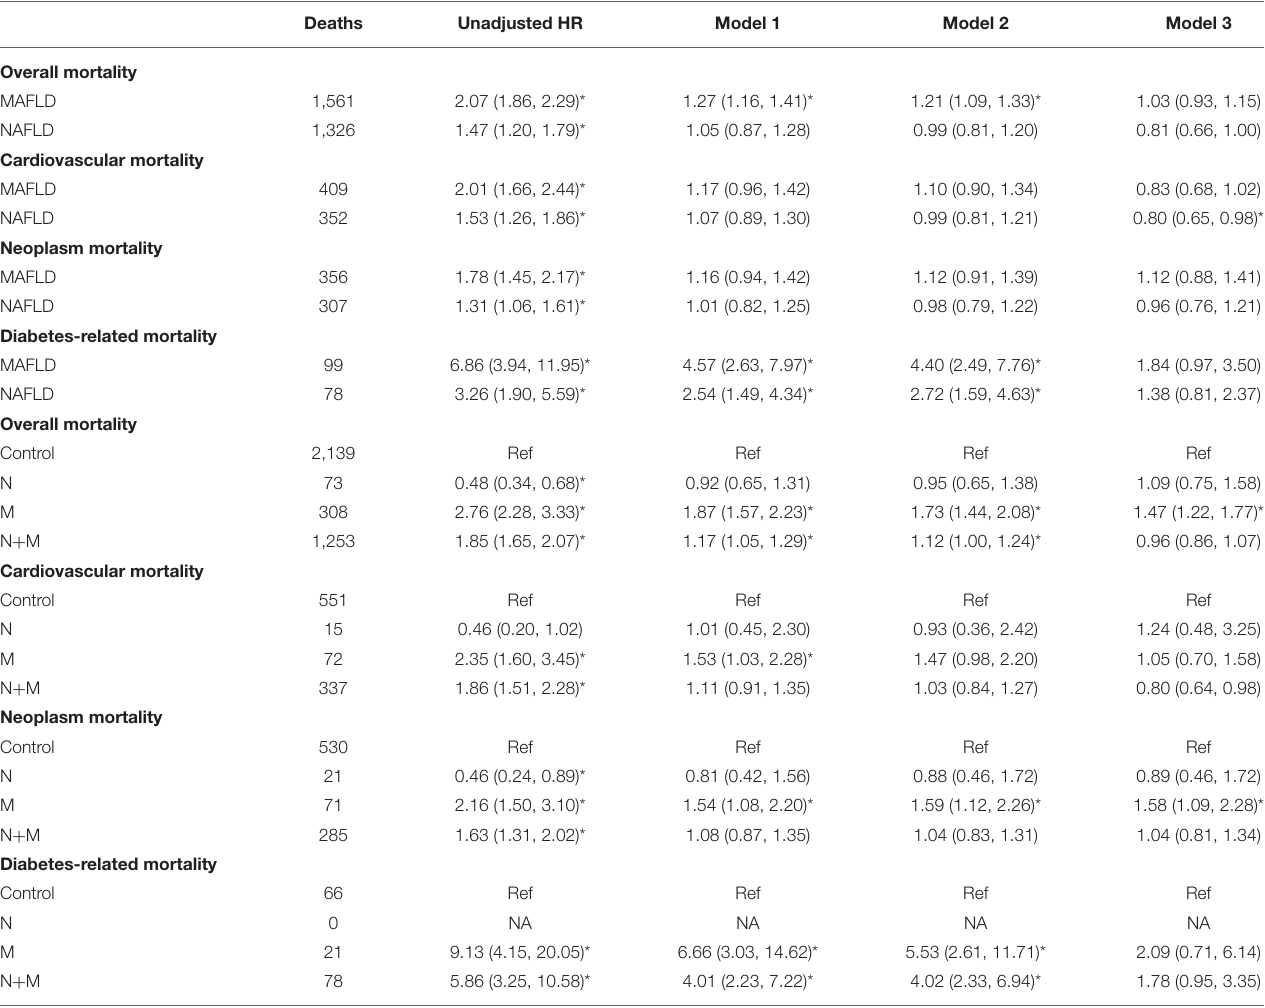
TABLE 2 | Cox regression model for overall and disease-specific mortality of participants. Deaths Unadjusted HR Model 1 Model 2 Model